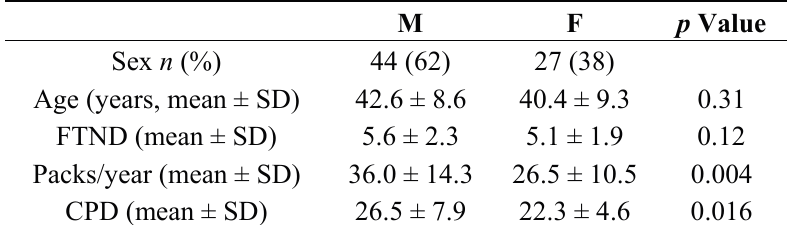
Table 1. Characteristics of the study sample at